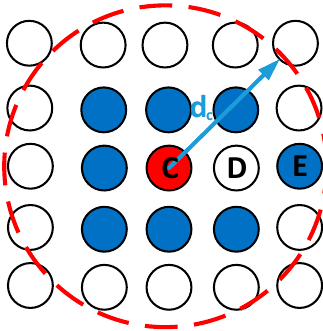
Figure 2. Schematic diagram of sample point C density calculation.